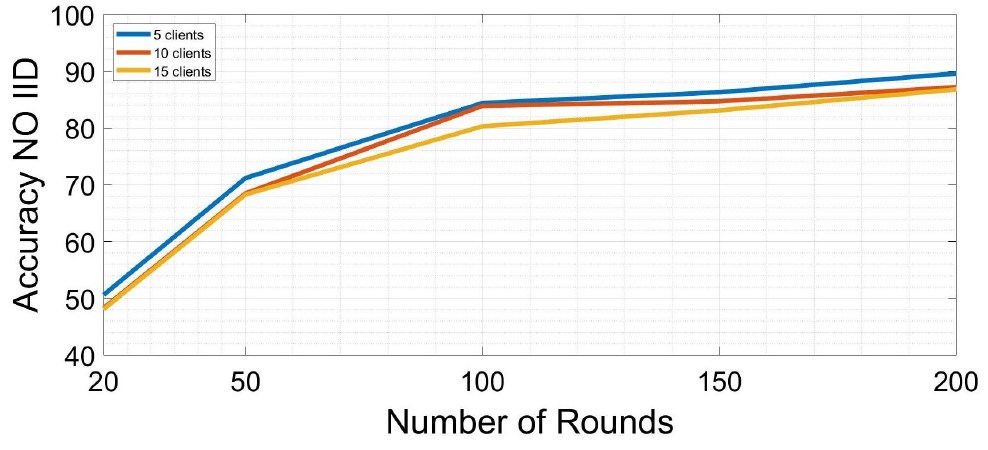
Figure 4. Accuracy in the scenario with NO-IID data when varying the number of clients.